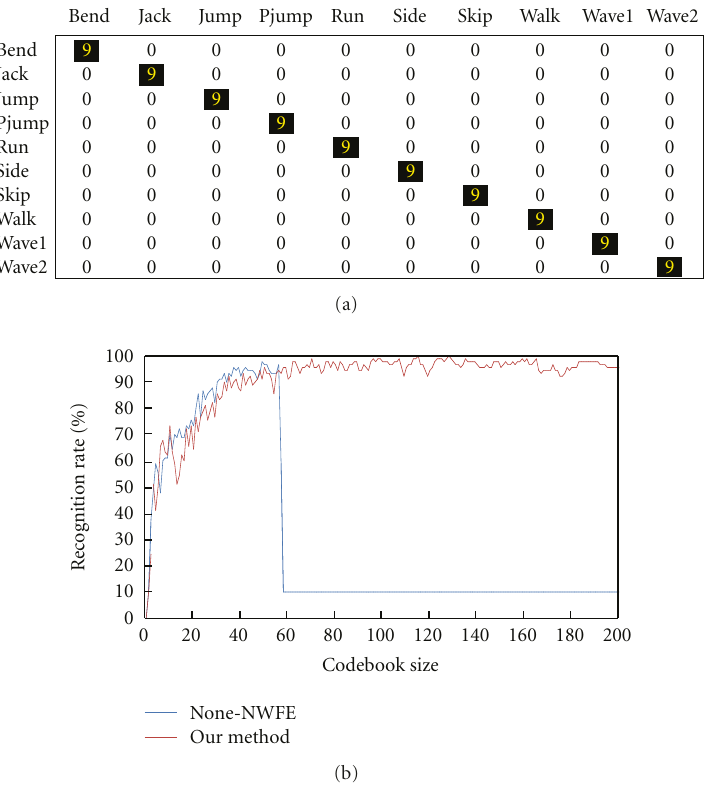
Figure 13: (a) Confusion matrix using 115 codewords. (b) Recognition rates versus codebook